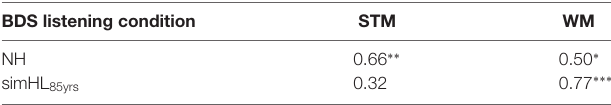
TABLE 1 | Spearman’s rank correlation coefficients for the relationship between listening condition (NH and simHL 85yrs ) for the BDS task and the two other types of memory tasks (STM and